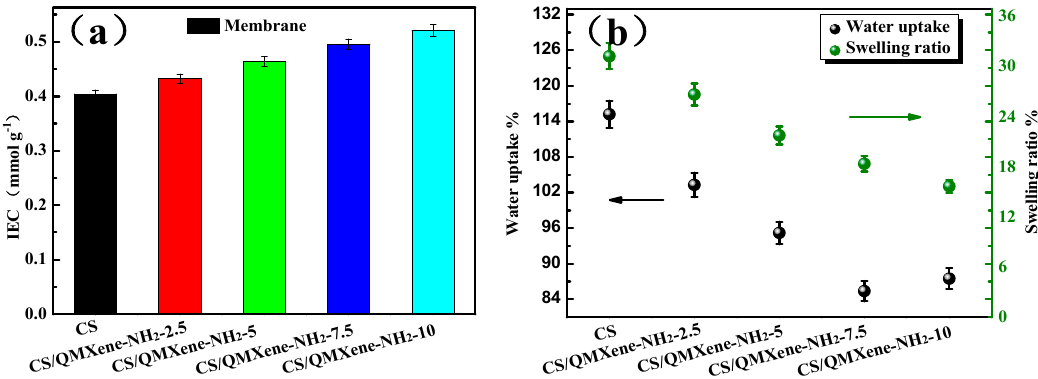
Figure 8. Filler content-dependent IEC values ( a ), water uptake ratios and swelling ratios ( b ) of control CS and CS/QMXene-NH 2 membranes.